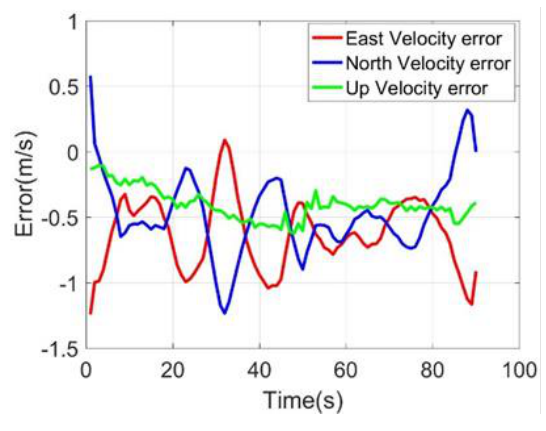
Figure 8. Three-axis positioning errors.